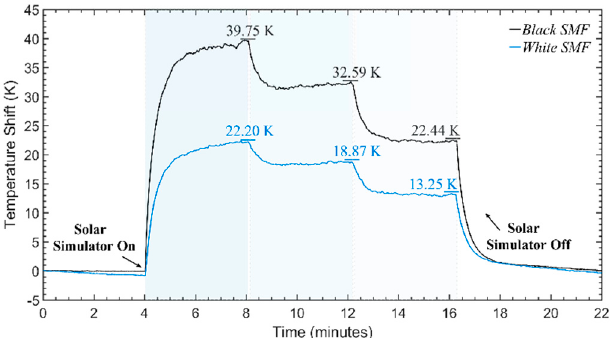
Figure 5. Temperature behavior obtained with the white fiber ( blue trace ), and with the black fiber ( black trace ), under ~4-minute solar irradiance cycles of 0 W/m 2 , 1000 W/m 2 , 750 W/m 2 500 W/m 2 , and 0 W/m 2 , at room temperature.